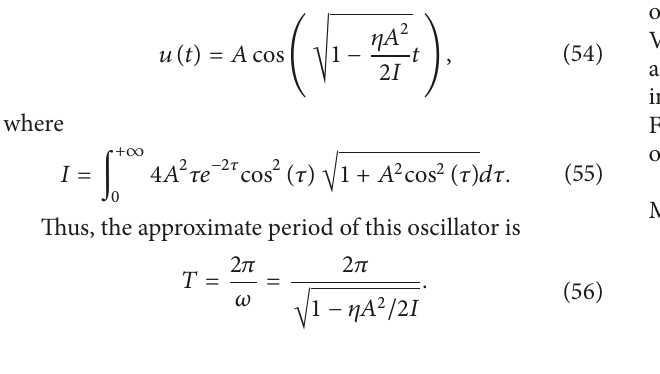
and the approximate solution of this